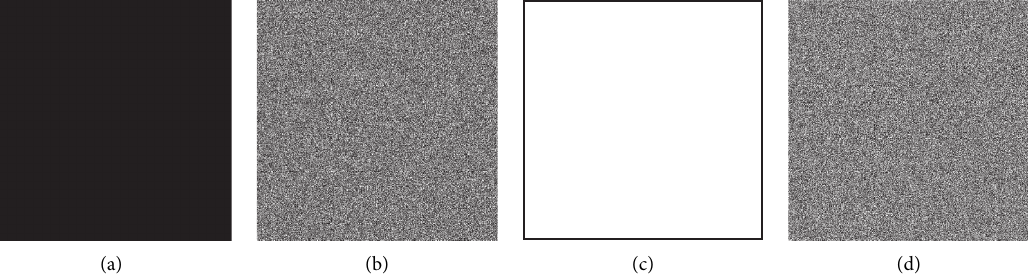
Figure 15: Results of the black and white images by the proposed algorithm. (a) Black plaintext; (b) black ciphertext; (c) white plaintext; (d) white ciphertext.